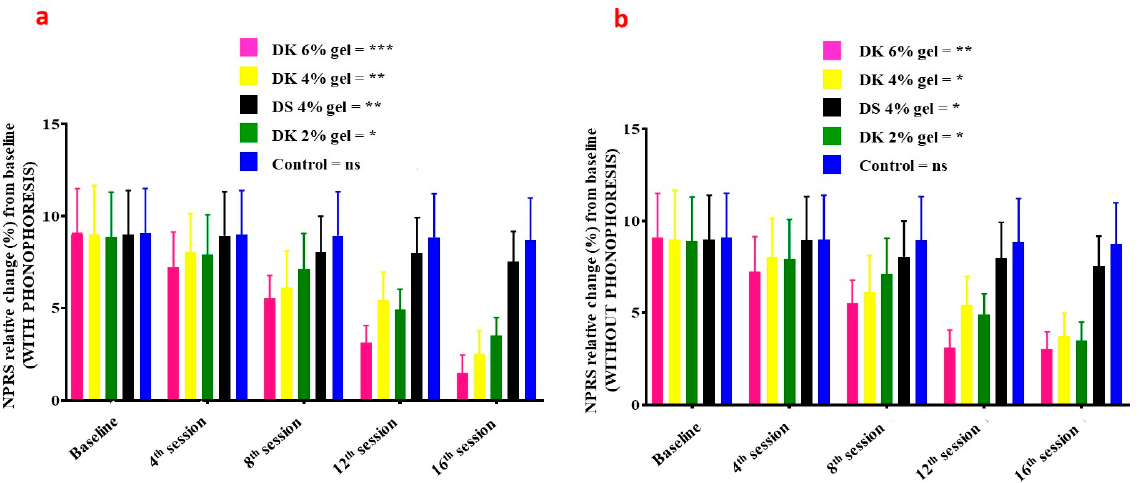
Figure 4. NPRS-related changes on the baseline, 4th session, 8th session, 12th session, and 16th session of Diclofenac potassium (DK) treatment ( a ) with phonophoresis ( b ) without phonophoresis, in sports-injured patients. Diclofenac sodium (DS) was used as a standard control. Control group is the placebo. Statistical significance ( p -values) is detailed in the main text. ns = no significant; p < 0.05 *, p < 0.01 **, p < 0.001 ***. NPRS: Numerical Pain Rating Scale.